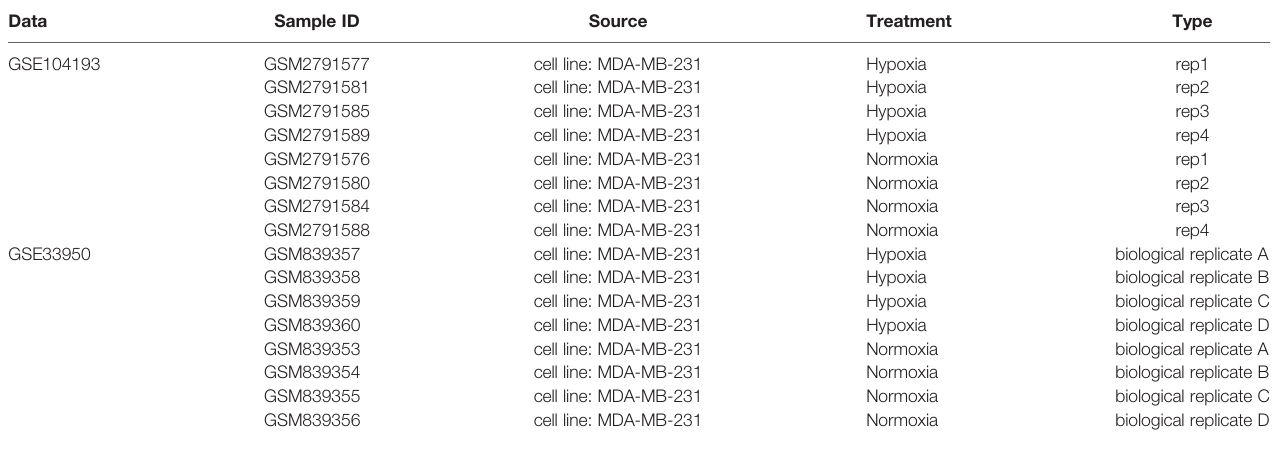
TABLE 1 | Information of data for differential expression analysis of normoxia and hypoxia cultured